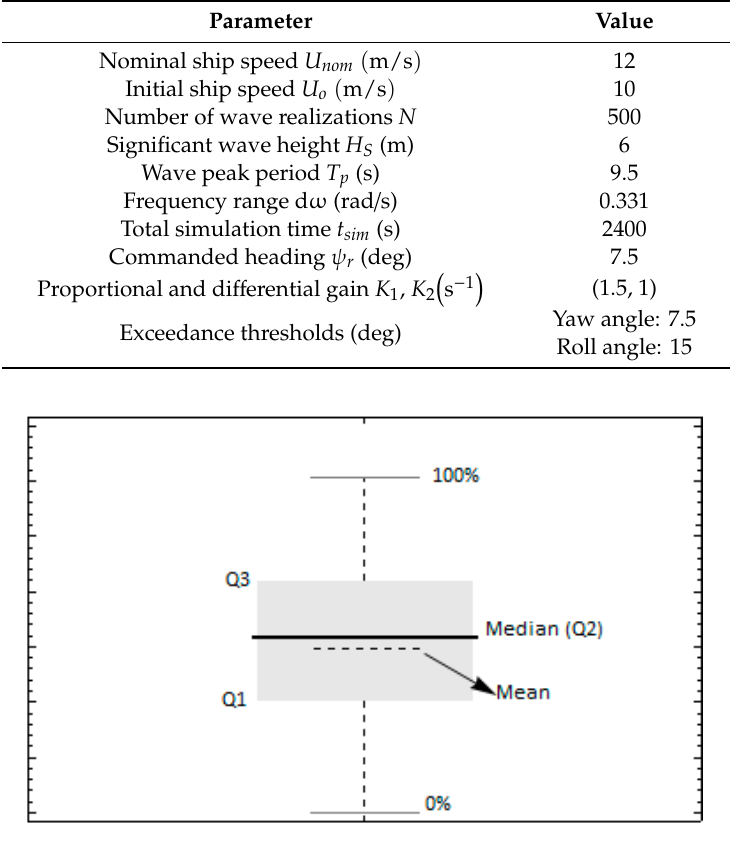
Figure 8. Sample graph presentation targeting the key statistical information.